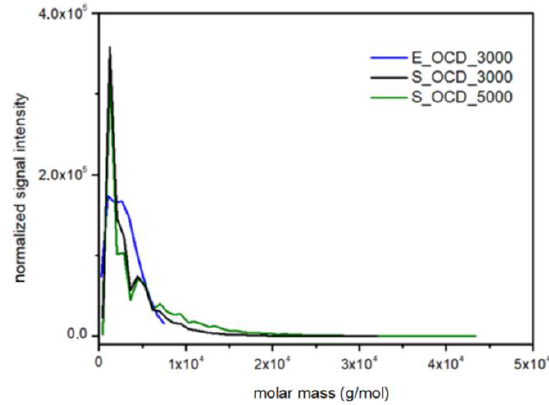
Figure 17. Dispersity (P w /P n ) as a function of the conversion of 1,10-decanediol added in the second stage of the synthesis.